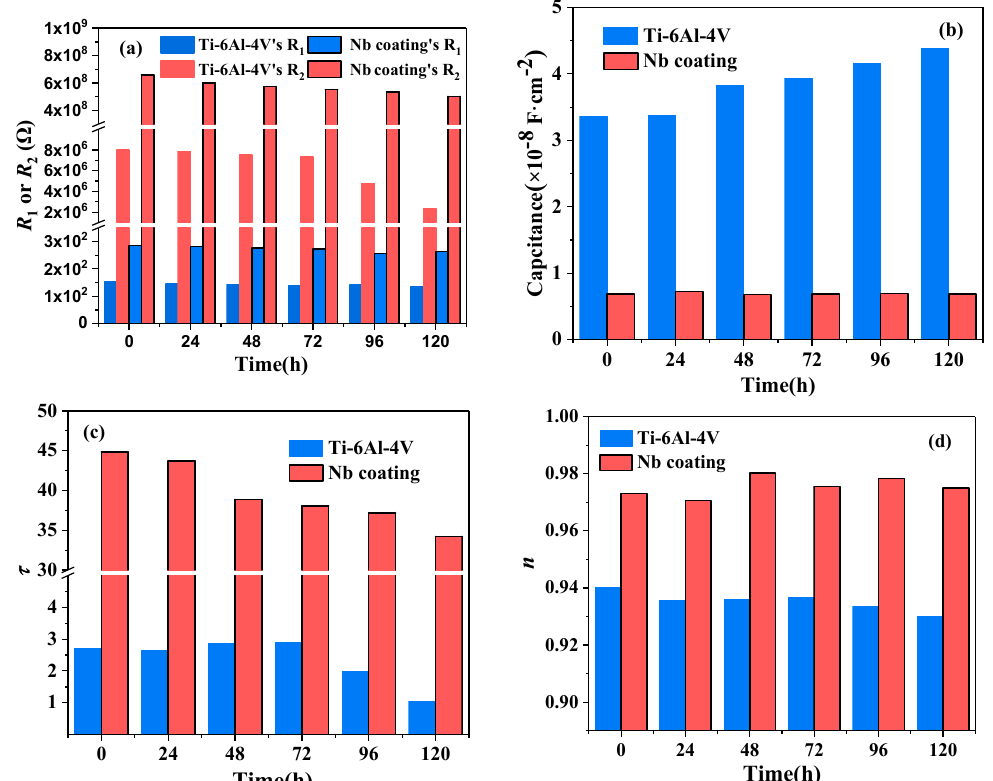
Figure 8. Impedance spectra fitting data of the test samples at the immersion time for five days. ( a ) Resistance values R 1 and R 2 ; ( b ) capacitance values C ; ( c ) time constant τ ; ( d ) CPE power n .